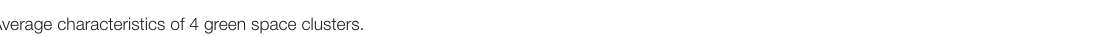
TABLE 3 | Average characteristics of 4 green space